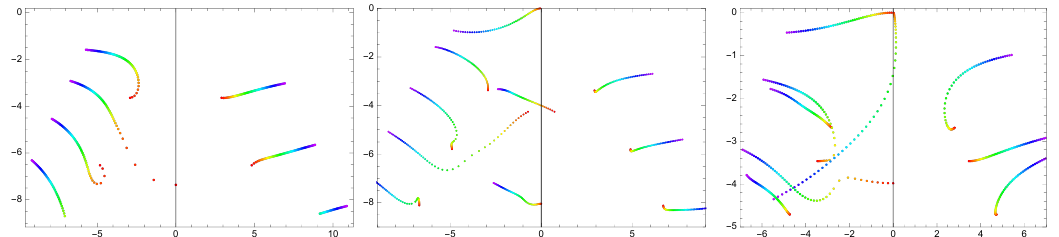
Figure 9 . Planar limit black brane QNMs (case (iii)). The planar brane QNMs are displayed in the complex frequency plane for a = 0 : 5. All the sectors are represented from left to right: tensor, vector, scalar. The linear momentum coers the range 0 < k < 5, indicated by the color (red to violet). The units are chosen such that r h = L = 1.